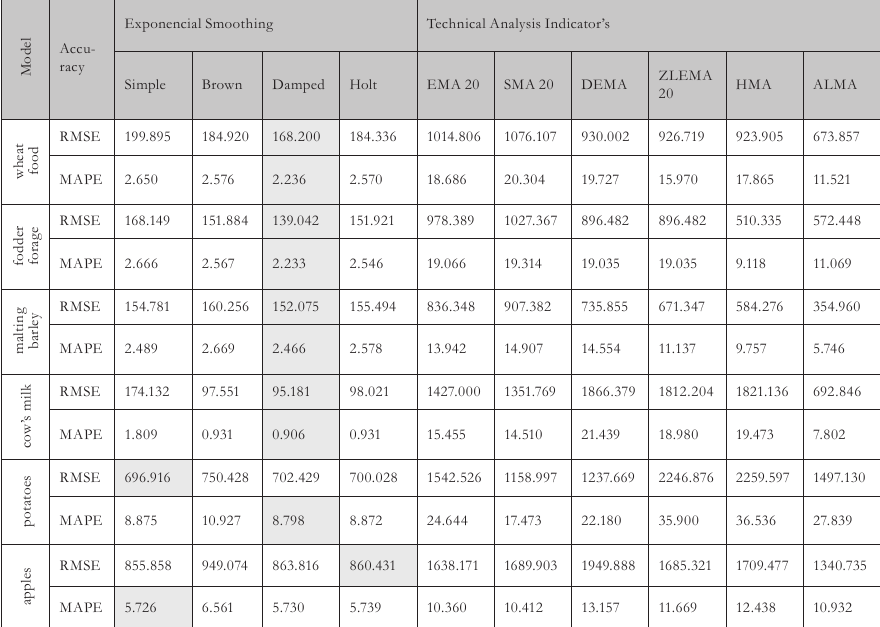
Tab. 2 – Results of Exponential Smoothing and Technical Analysis Indicator’s with Basic Parameters. Source: